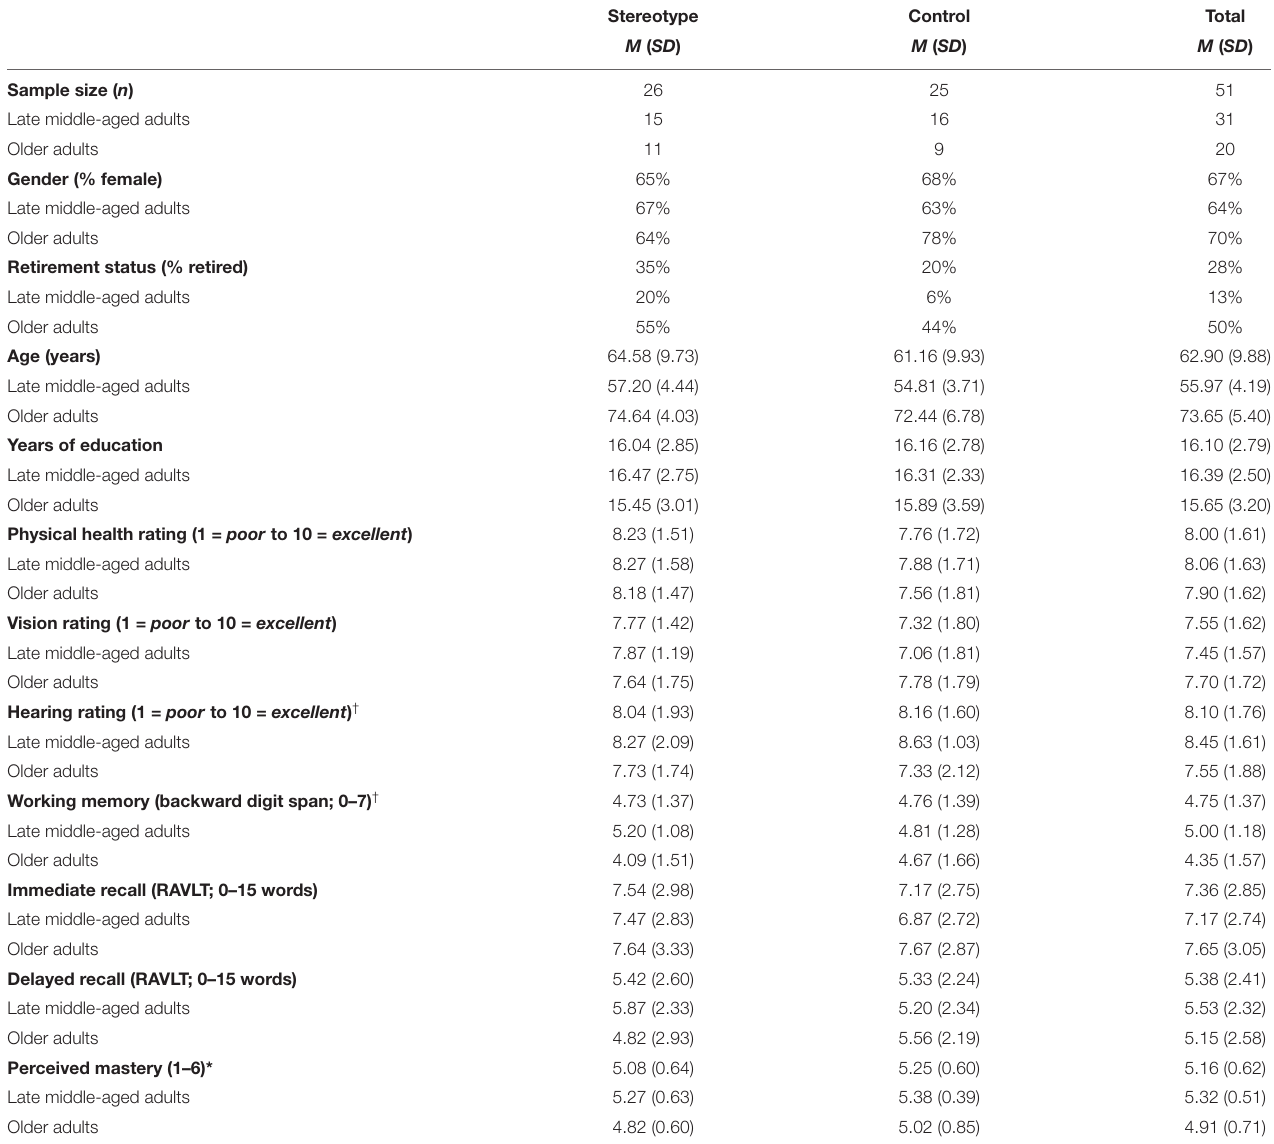
TABLE 1 | Demographics and background information by experimental condition and age group.